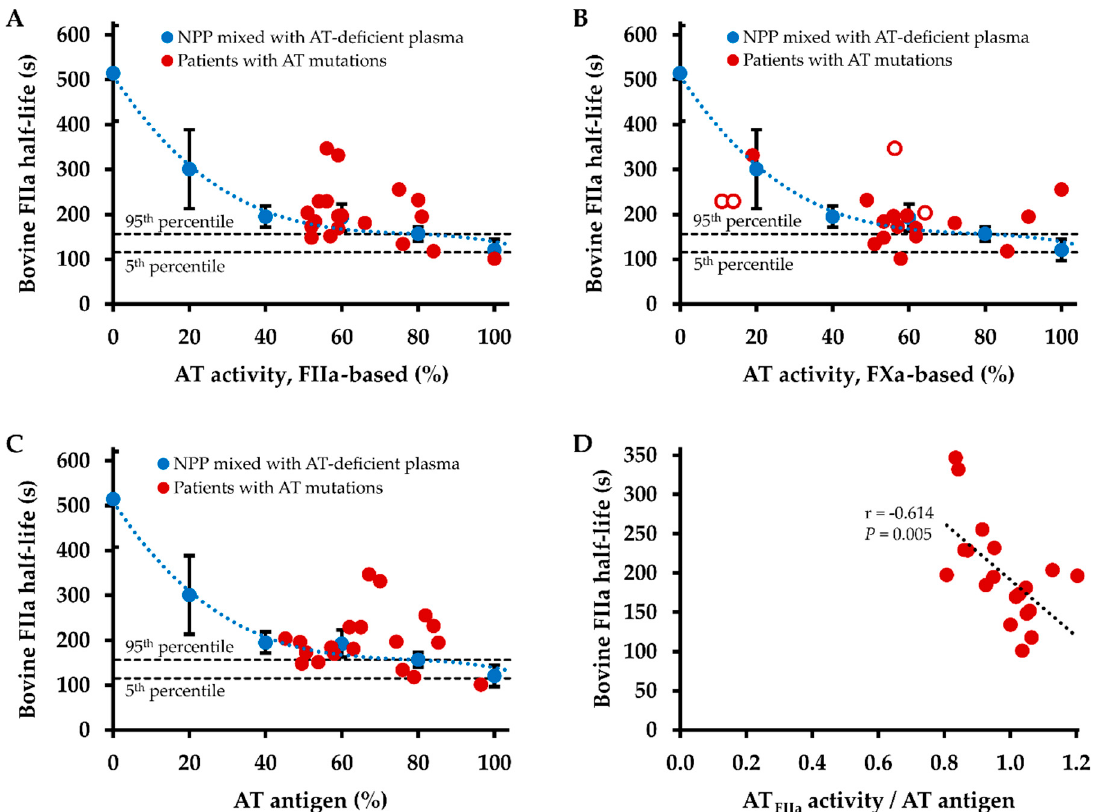
Figure 4. Dependence of inhibition kinetics of bovine thrombin (FIIa) on antithrombin (AT) plasma levels. ( A ) The half-life of exogenously added bovine thrombin (2 ng/mL final concentration) was determined in citrated plasma obtained from patients with AT mutations (red circles, n = 19) and in normal pooled plasma (NPP) mixed with AT-deficient plasma to achieve the indicated AT levels (blue circles). Data points in blue represent means of three independent determinations on three different days, error bars represent the standard deviation. The intersected lines parallel to the x-axis indicate the 95th and 5th percentiles of half-life times measured in healthy controls ( n = 26). Functional AT levels were determined by a thrombin-based assay. ( B ) Functional AT levels were determined by an activated factor X (FXa)-based assay. Data points filled white indicate plasma from patients under therapy with FXa inhibitors. ( C ) AT antigen levels were determined by an immunoassay. ( D ) Correlation of the ratio of AT activity determined by a FIIa-based assay and AT antigen concentration with the plasma half-life of exogenously added bovine thrombin. r indicates the Pearson correlation coefficient.